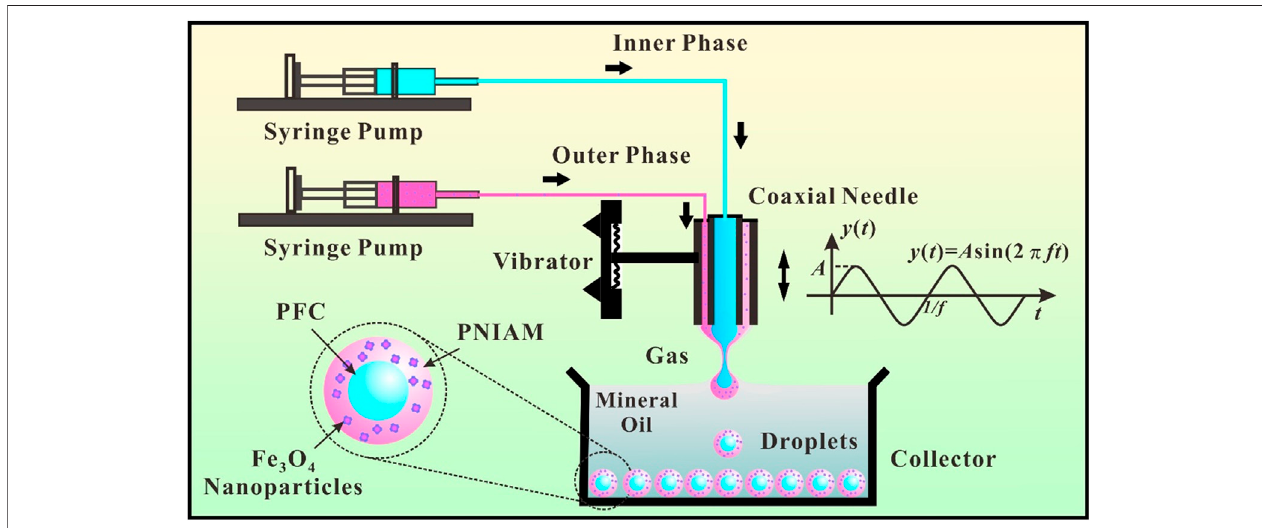
FIGURE 1 | Schematic illustration of an on-demand coaxial interface shearing (CIS) double emulsion generation system including a coaxial needle, two syringe pumps, an electric vibrator, and a collecting pool.